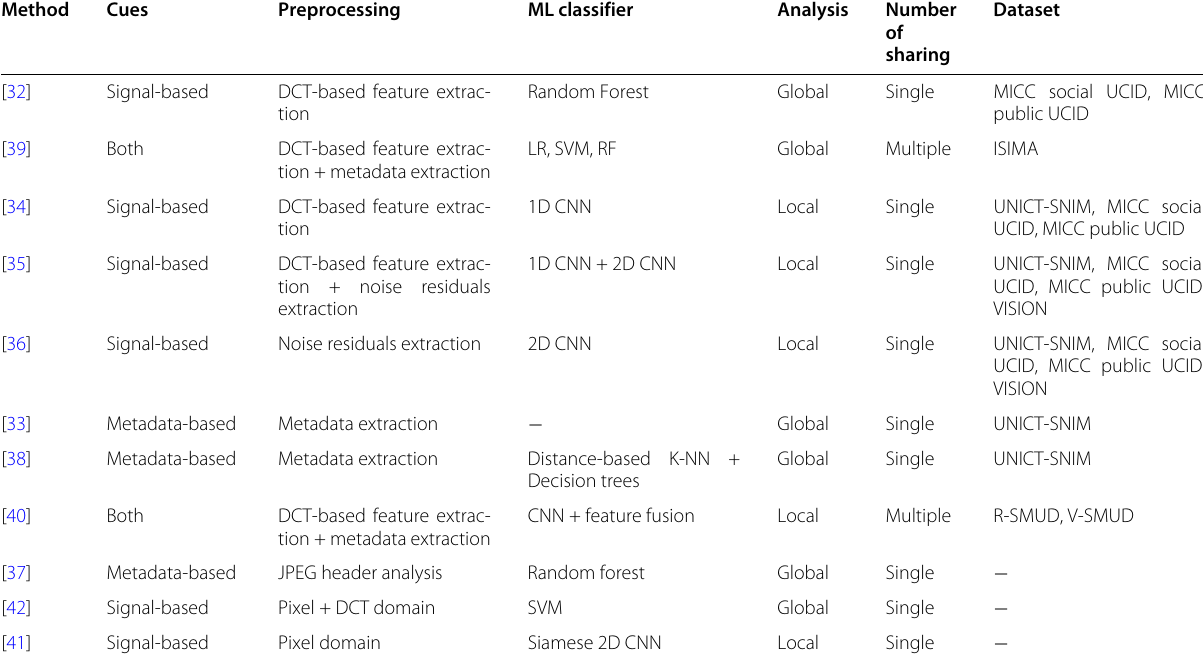
Table 4 Summary of platform provenance analysis approaches. The column “Analysis” indicates whether the detectors operate on the full image (“Global”) or on image patches (“Local”)